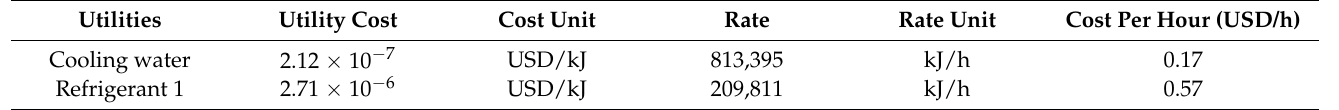
Table 10. Utilities used in the bio-refinery